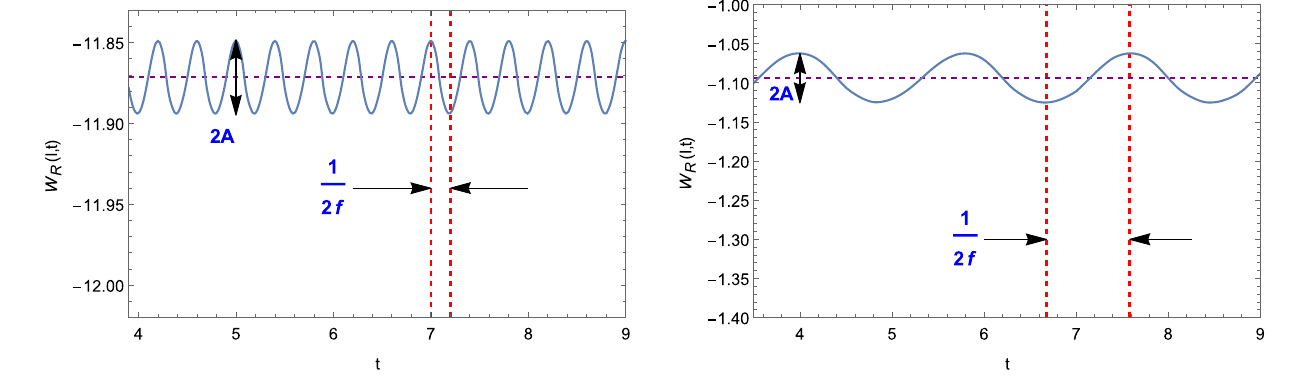
Fig. 6 The expectation value of the Wilson loop in terms of boundary time for ν = 4, k = 0 . 3, T = 0 . 159 and l = 1 ( l = 1 . 5 ) for the left (right) figure. The oscillation frequency is 2 . 5 ( 0 . 6 ) for the left (right)